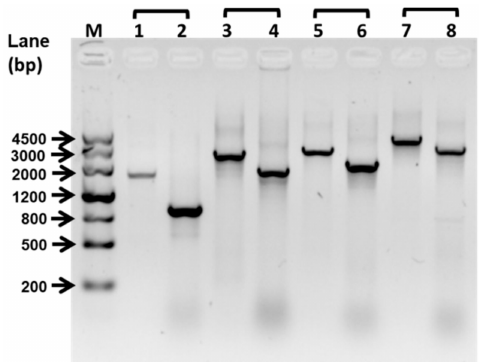
Figure 1. Deletion of flagellin synthetic protein gene fliP . The deletion of the fliP gene was confirmed by PCR. The PCR product sizes of the wild-type strain were 1637 bp (line 1, fliP –SF / fliP –SR), 2558 bp (line 3, fliP –SF / fliP –LR), 2805 bp (line 5, fliP –LF / fliP –SR), and 3726 bp (line 7, fliP –LF / fliP –LR). The PCR product sizes of ∆ fliP strain were 896 bp (line 2, fliP –SF / fliP –SR), 1817 bp (line 4, fliP –SF / fliP –LR), 2064 bp (line 6, fliP –LF / fliP –SR), and 2985 bp (line 7, fliP –LF / fliP –LR). M,